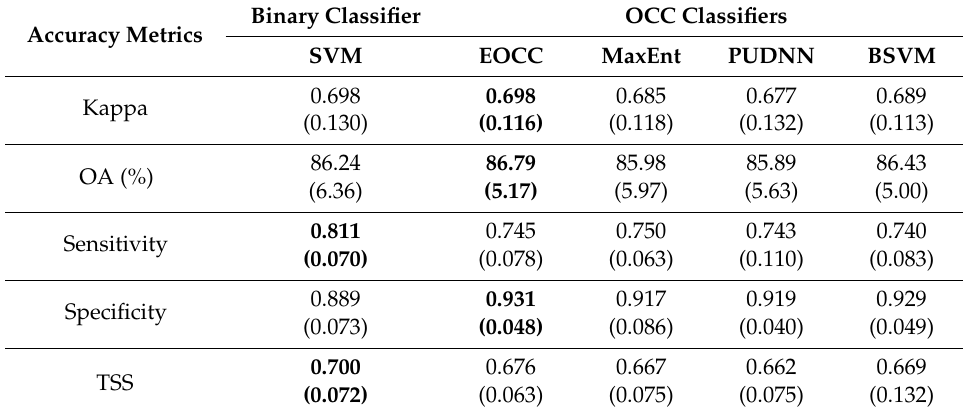
Table 5. Mean and standard deviation of OA, Kappa, sensitivity, specificity, and TSS of the SVM and OCC classifiers in 12 Scenarios 1 and 2. Values in parentheses are standard deviations. The best result of each accuracy metric was